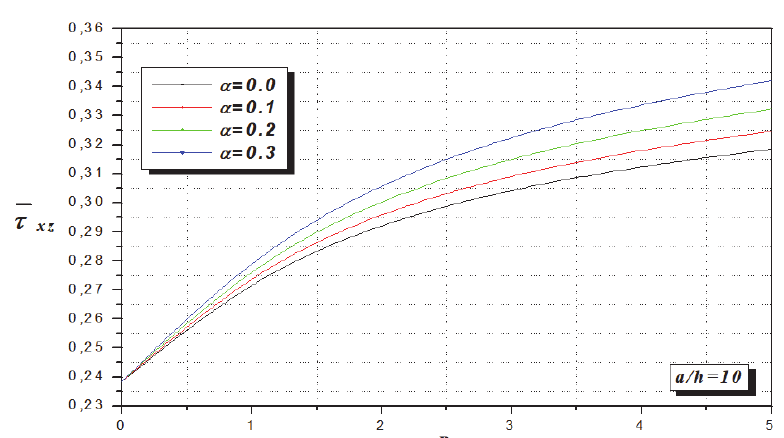
 as a function of the power index P and the different porosity factor α xz